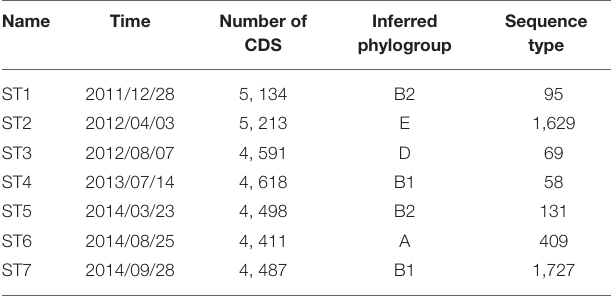
TABLE 1 | Characteristics of the seven dominant strains recovered from metagenomic